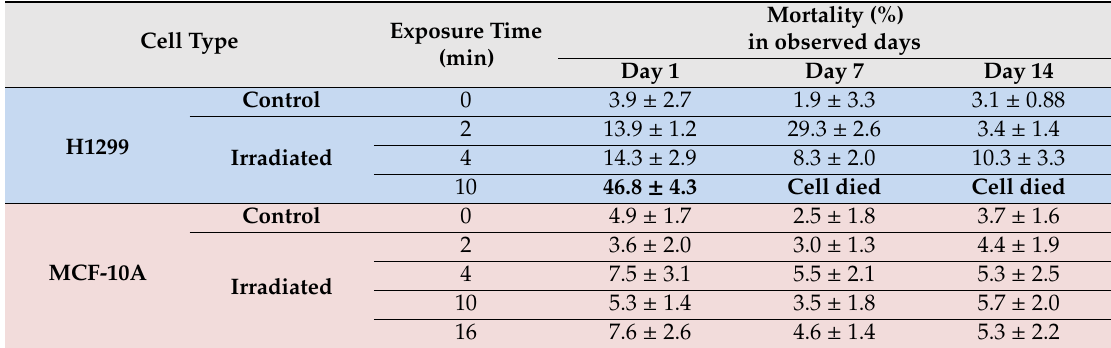
Table 5. Summary of the mortality e ff ect following W-band (75–105 GHz) MMW treatment on H1299 and MCF-10A cell lines.